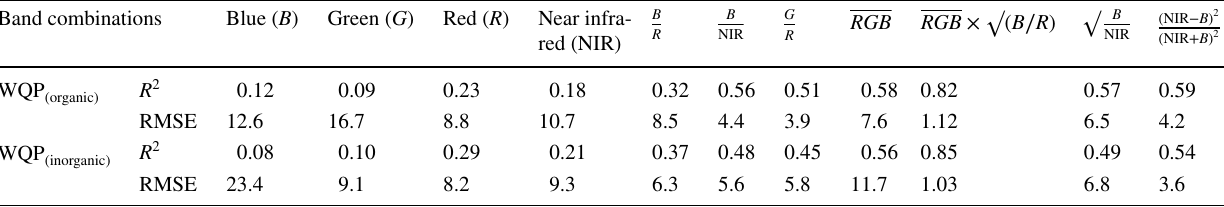
Table 2 Coefficient of determination R 2 and RMSEs for spectral bands and their combinations for calibration data set Band combinations